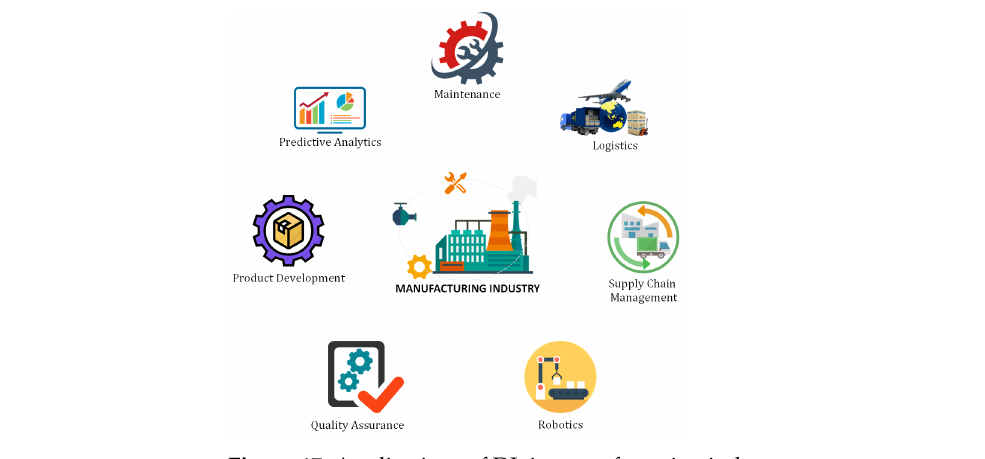
Figure 17. Applications of DL in manufacturing industry. Table 6. State-of-the-art contributions in DL-based manufacturing